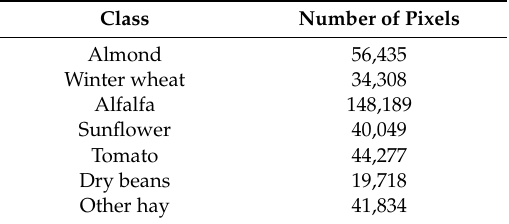
Table 2. Number of pixels for each of the 7 classes in study area